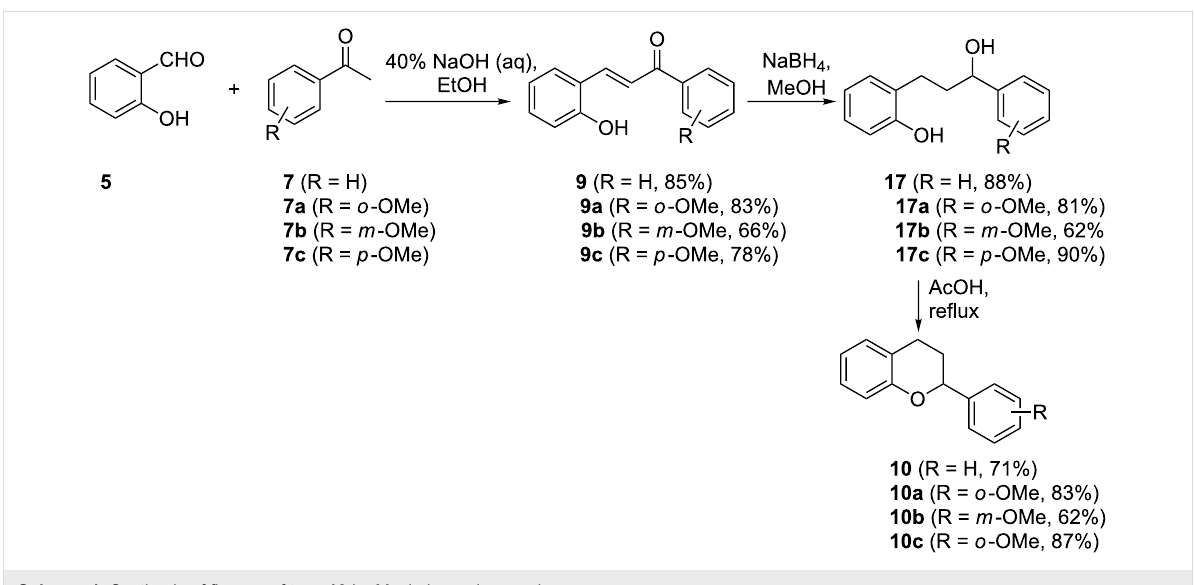
must either be isomerized to the cis form or completely reduced. In this case, chalcone 14 was treated with H 2 in the presence of a catalytic amount of Pd to give intermediate 15 in 99% yield. It is instructive to draw attention to the fact that both the carbon–carbon and carbon–oxygen double bonds of 14 were reduced by H 2 /Pd, a reagent usually used for the reduction of carbon–carbon double bonds. To complete the synthesis, Lewis acid mediated cyclization of intermediate 15 and acidic cleavage of the MOM protected hydroxy group delivered the desired flavan 16 in good